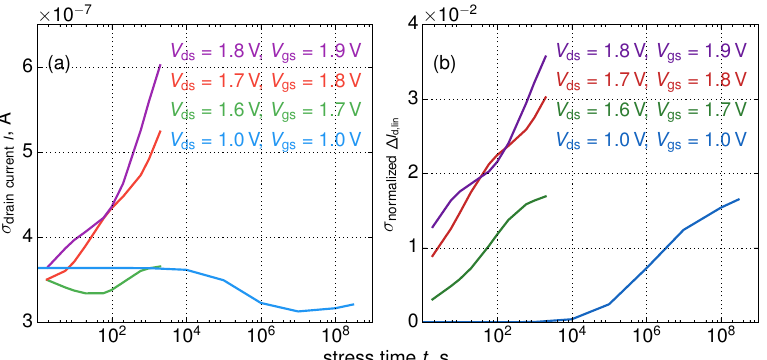
Figure 5. The standard deviations of the linear drain I d,lin ( a ) and the relative linear drain current change ∆ I d,lin ( b ) as functions of stress time t